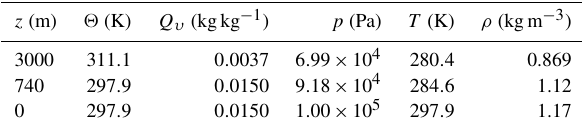
Table 1. Initial profiles for the KiD warm-1